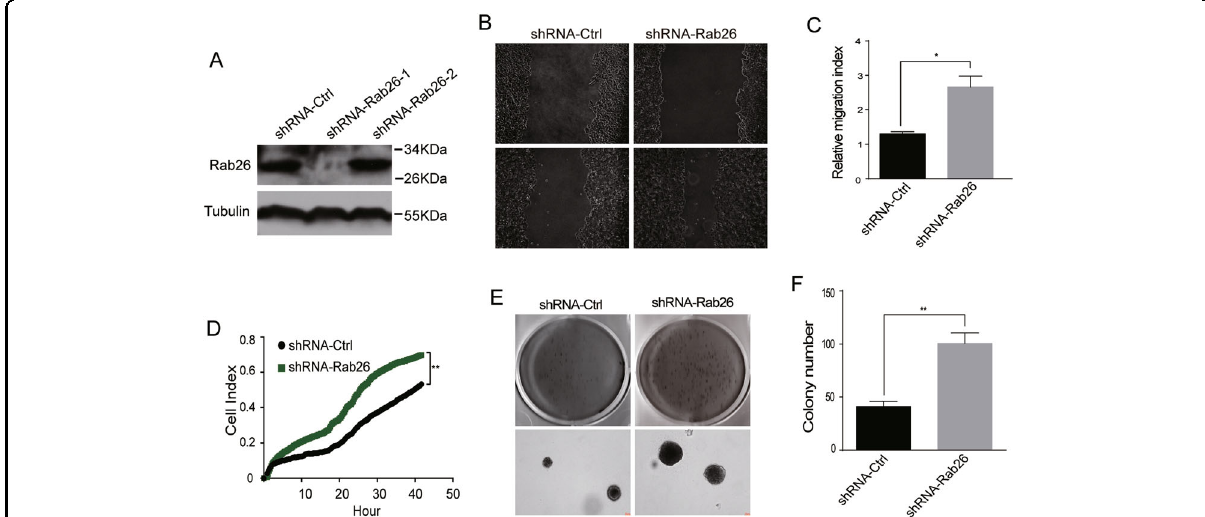
Fig. 3 Rab26 knockdown promotes migration and invasion of breast cancer cells. A Western-blot showed shRNA-Rab26-1 ef fi ciently depleted Rab26 in MCF7 cells. B Wound-healing assays showed Rab26 knockdown promotes migration of MCF7 cells. C Quantitative analysis of the wound area using imageJ software from three independent wound-healing experiments, * p < 0.05. D RTCA matrigel invasion assays showed Rab26 knockdown promotes invasion of MCF7 cells. ** p < 0.01. E Double-layer soft agar experiments show that Rab26 knockdown promotes colony formation of MCF7 cells in soft agars. F Quantitative analysis of the results of E from three independent experiments. ** p <